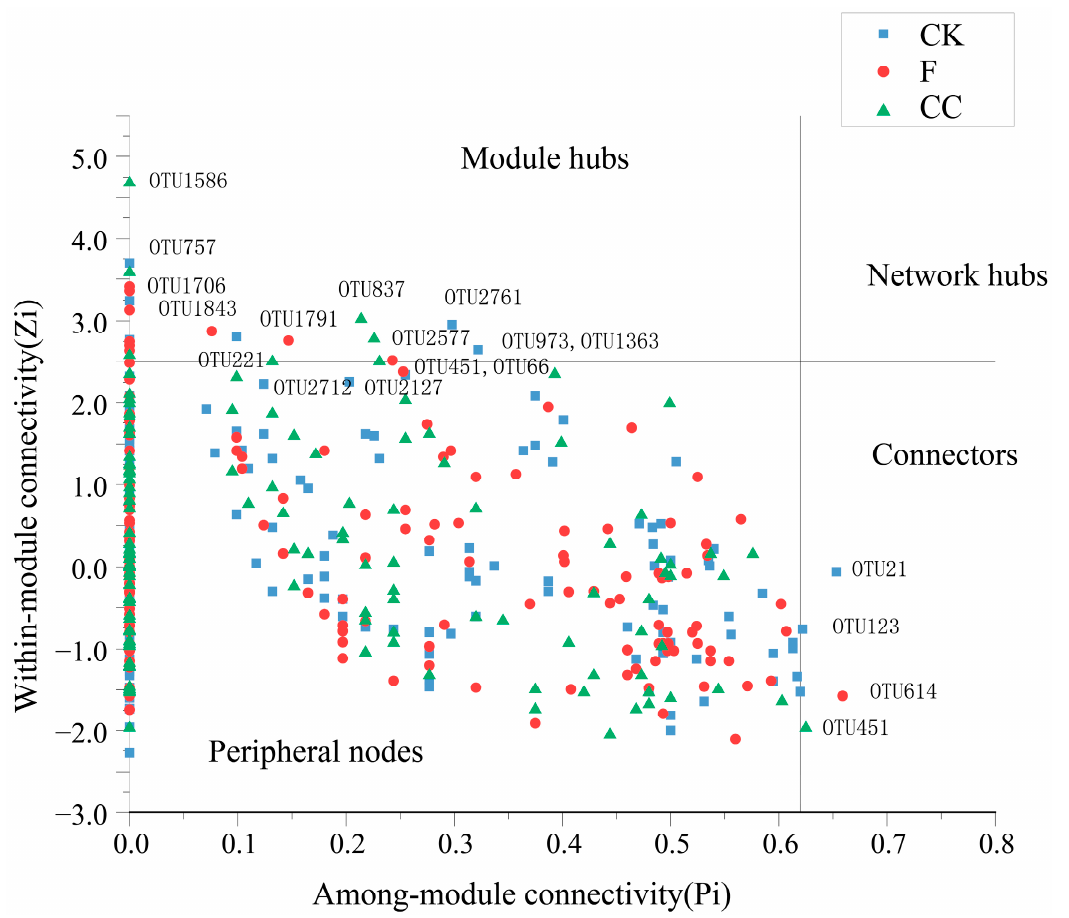
Figure 7. Z-P plot based on OTUs’ topological roles. Each symbol represents an OTU in the CK (blue), F (red), and CC (green) treatments. The module hubs and connectors are labeled with OTU numbers.